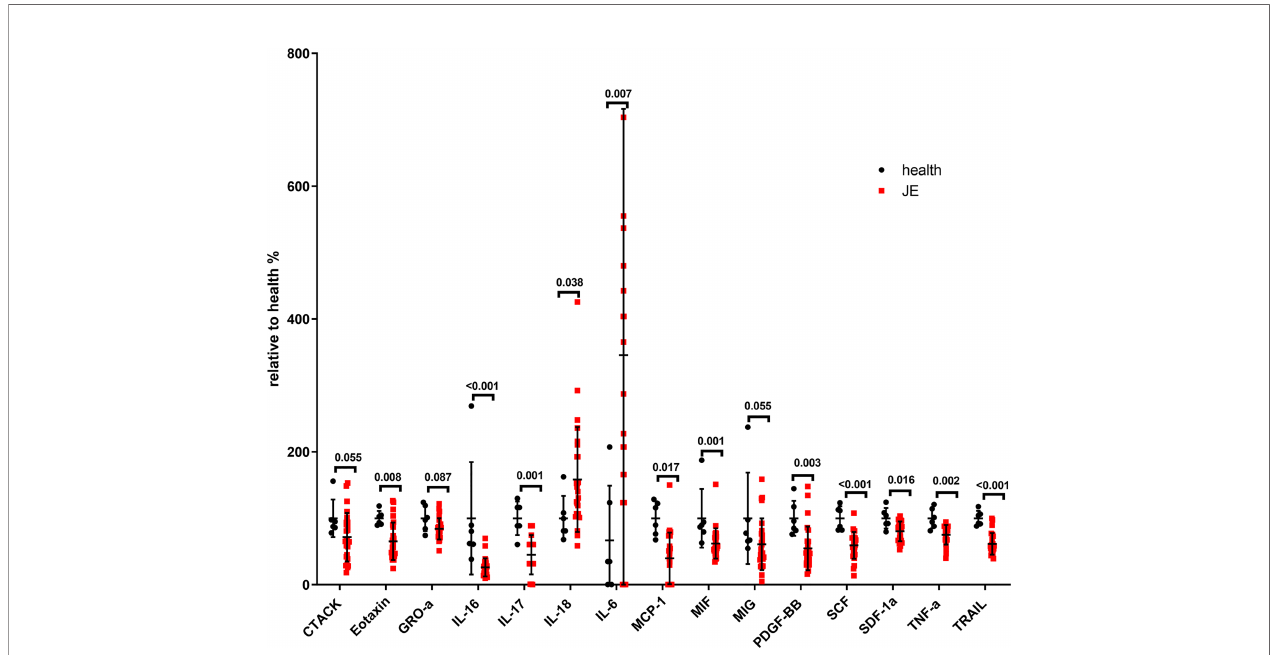
FIGURE 2 | The signi fi cant change of total main cytokines in JE patients relative to the health. Series of cytokines in the plasm of healthy controls (n = 6) and JE patients (n = 26; these data were from the plasma of JE cases on the fi rst day they were hospitalized. The Mann – Whitney U test was used to compare differences in median values between two groups. p <0.05 was considered statistically signi fi